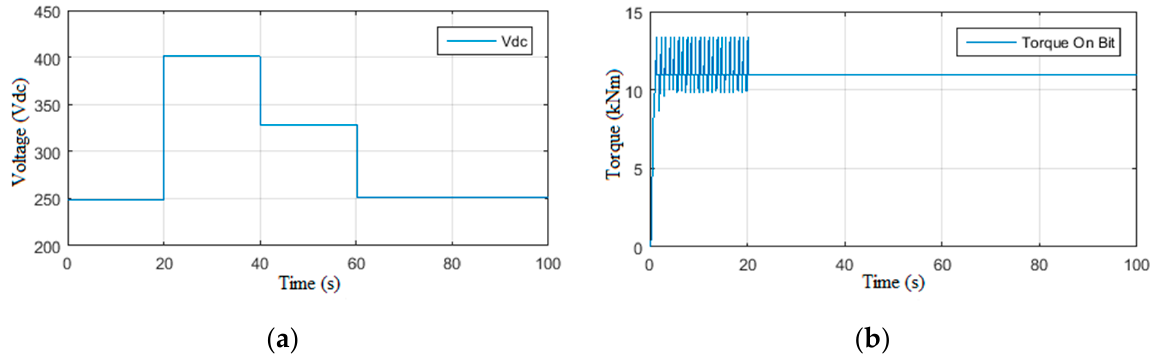
Figure 6. Responses of open loop scenario 1.2: ( a ) Voltage of the load, ( b ) Torque on bit (Tob).